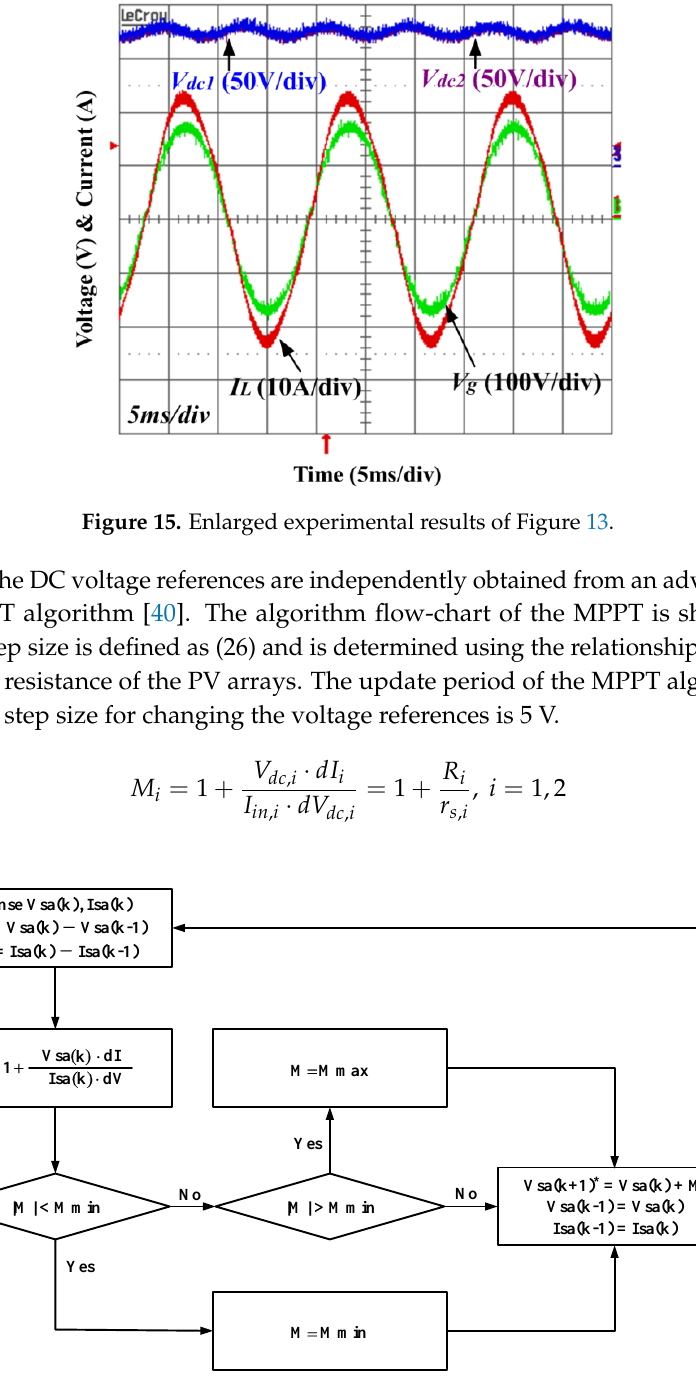
Figure 16. Algorithm flow-chart of the advanced incremental conductance method.